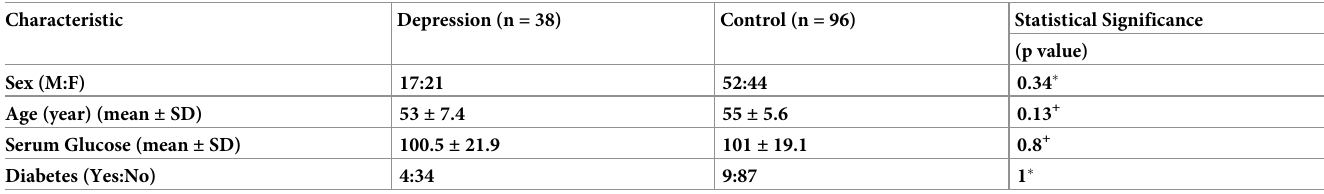
Table 1. Demographic characteristics of multiple myeloma patients with and without